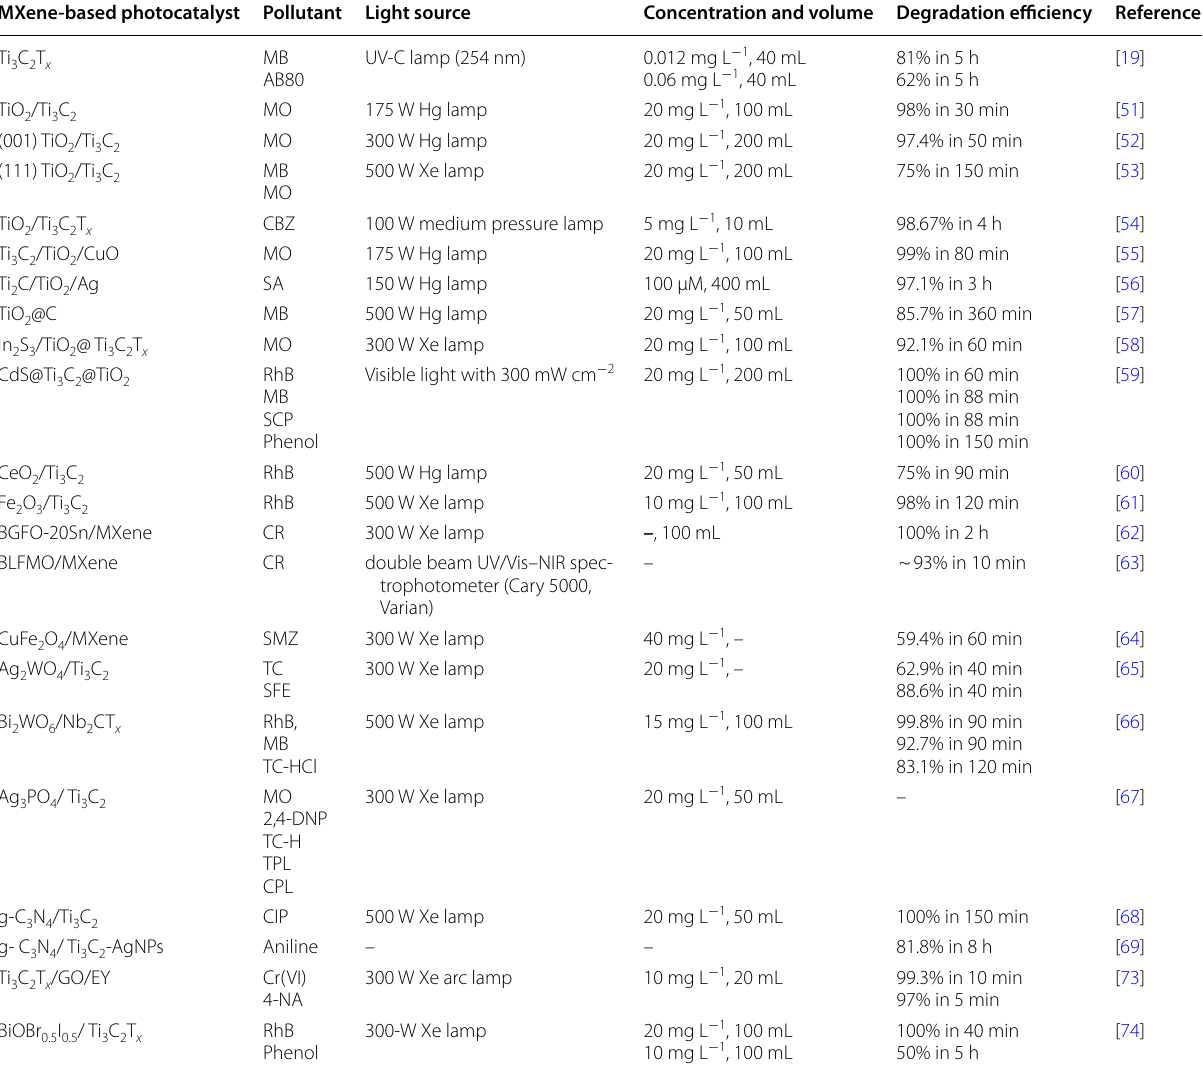
BGFO-20Sn Gd and Sn co-doped bismuth ferrite BiFeO 3 nanoparticles, BLFMO La and Mn co-doped bismuth ferrite BiFeO 3 nanoparticles, CR Congo red, MB methyl blue, AB80 acid blue 80, MO methyl orange, CBZ Carbamazepine, RhB Rhodamine B, SCP sulfachloropyridazine, SA salicylic acid, 2,4-DNP 2,4-Dinitrophenol, TC-H tetracycline hydrochloride, TPL thiamphenicol, CPL chloramphenicol, SMZ sulfamethazine, SFE sulfadimidine, CIP ciprofloxacin, 4-NA 4-nitroaniline